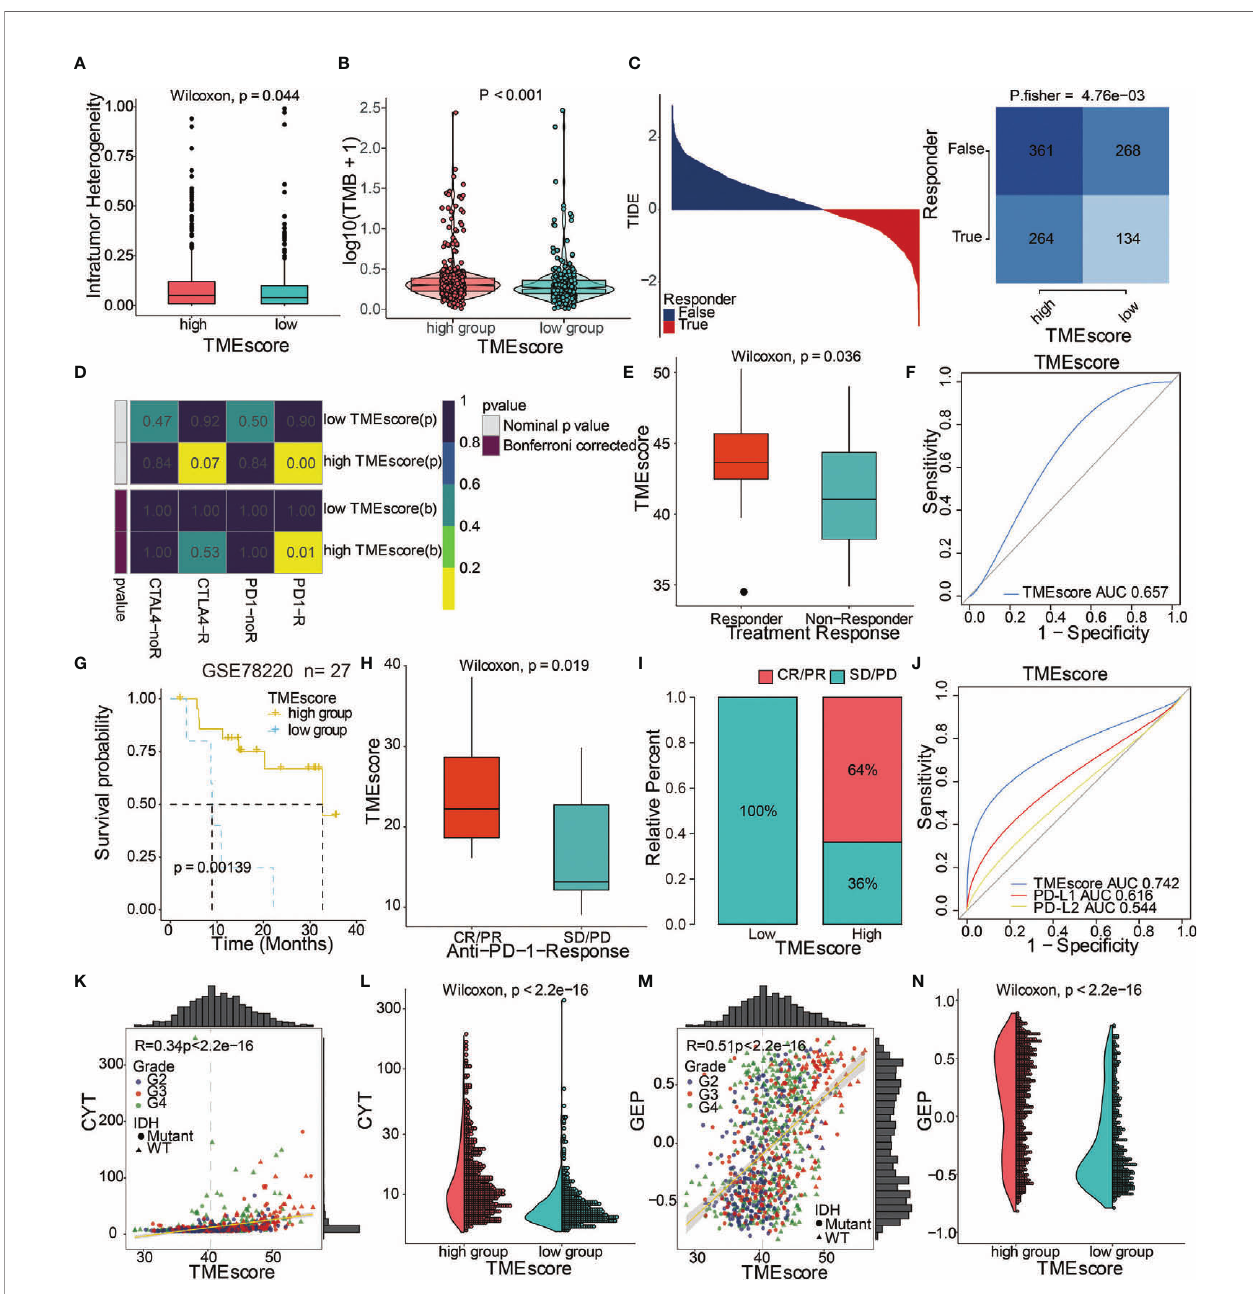
FIGURE 6 | TME-score is a prognostic biomarker and predicts immunotherapeutic bene fi t. (A) Intratumor heterogeneity in high and low TME-score. (B) TMB in high and low TME-score. (C) TIDE value and response to immunotherapy of patients with TME-scores. (D) Submap analysis based on the TIDE algorithm showed a signi fi cant difference in response to CTLA-4 and anti- PD-1 therapy with respect to the TME-score in TCGA. (E) TME-scores in groups with a response and non-response to anti – PD-1 . Differences between groups were compared by the Wilcoxon test (Wilcoxon, P = 0.036). (F) Predictive value of the TME-score measured by ROC curves in the GSE35640 cohort. AUC is 0.657. (G) Kaplan – Meier curves for high and low TME-score patient groups in the GSE78220 cohort. Log-rank test, P = 0.00139. (H) TME-scores in groups with different anti – PD-1 clinical response status (CR/PR and SD/PD). Differences between groups were compared by Wilcoxon test (Wilcoxon, P = 0.019). (I) Rate of clinical response (CR/PR, SD/PD) to anti – PD-1 immunotherapy in high or low TME-score groups in the GSE78220 cohort. (J) Predictive value of the TME-score, PD-L1, and PD-L2 measured by ROC curves in the GSE78220 cohort. AUC is 0.742. Scatter plots depicting a positive correlation between TME-score and (K) CYT and (M) GEP. Pearson Correlation Coef fi cient R = 0.34 and 0.51, respectively. (L) CYT and (N) GEP expression differences in high and low TME-scores. Differences between groups were compared through the Wilcoxon test (Wilcoxon, P <